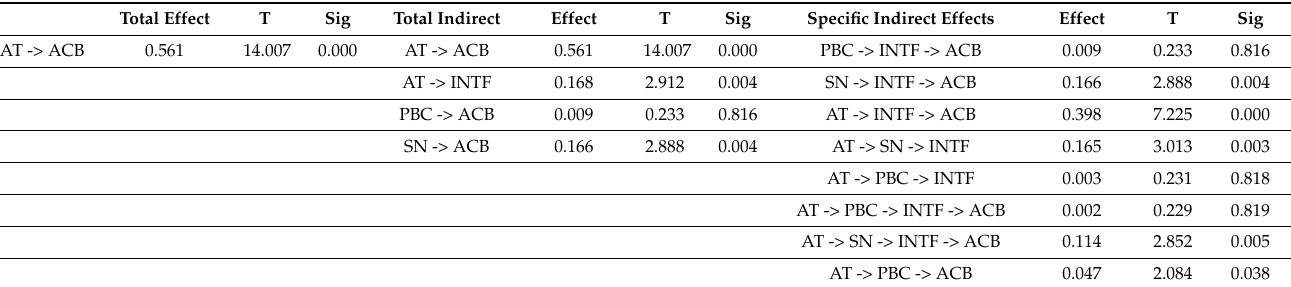
Table 10. Total, specific, and indirect effect between the independent variables and dependent variables. T represents the t-statistics while Sig represents the significance or p value in the re- search